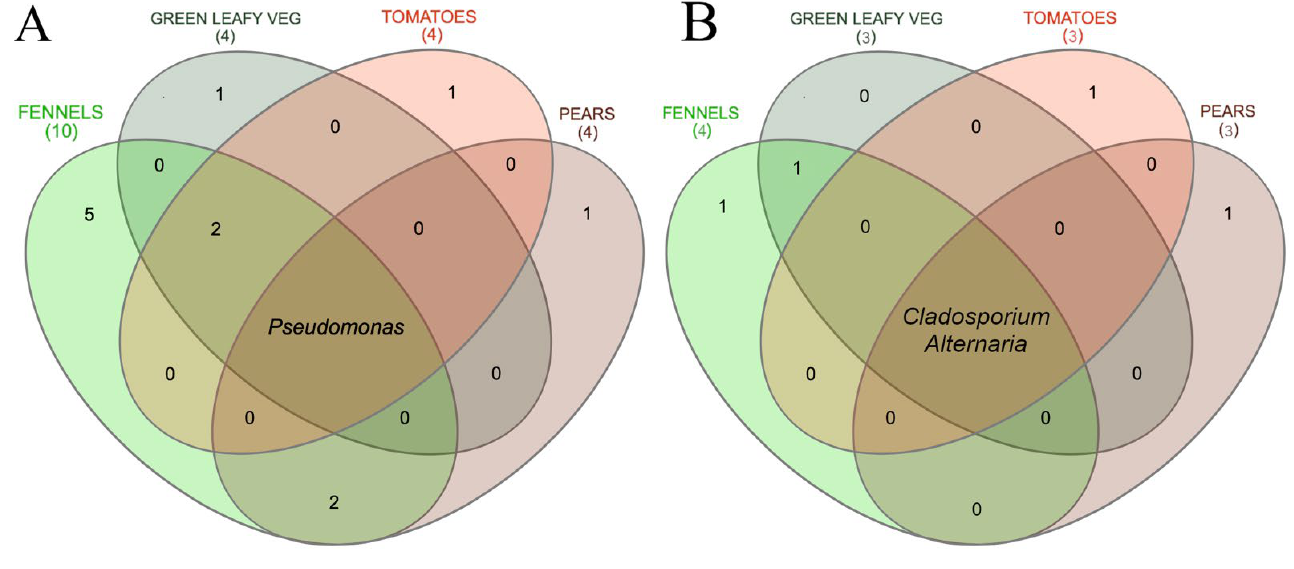
Figure 1. Venn diagrams showing the ( A ) bacterial and ( B ) fungal genera shared among different F&V. Only taxa with a relative abundance > 0.5% in at least 80% of samples in each type of F&V are included. The number of taxa retained after the filtering for each type is reported in parenthesis.